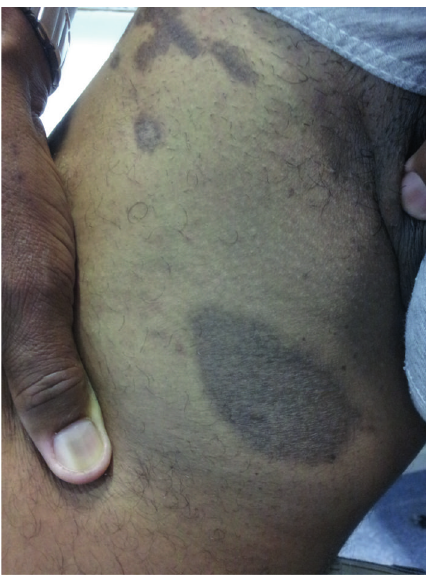
Figure 1: Hyperpigmented plaques of various sizes. Observe the atrophic